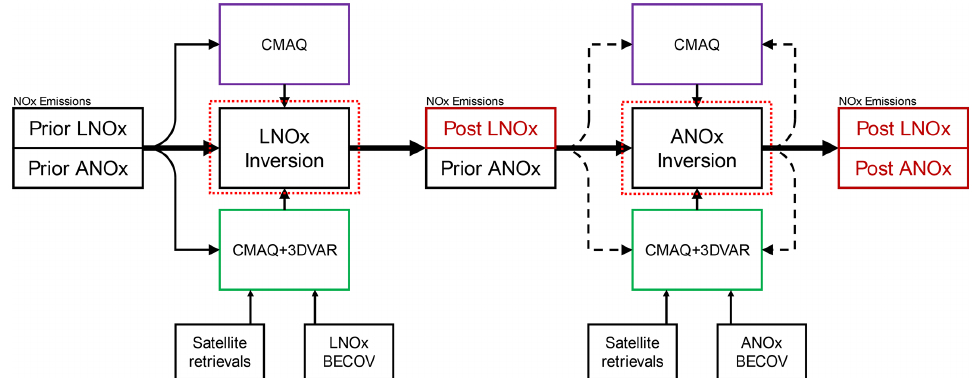
Figure 1. NO x emissions inversion framework. Lightning NO x (LNO x ) emissions are updated in the first step. Then, anthropogenic NO x (ANO x ) emissions are updated iteratively. CMAQ boxes represent air quality simulations without chemical data assimilation, and CMAQ + 3DVAR boxes represent air quality model simulations with chemical data assimilation. Satellite NO 2 retrievals and a background error covariance (BECOV) are inputs to the chemical data assimilation, described in Sect. 2.3. Red dotted lines around the inversion boxes correspond to the red dotted lines in Fig. 3, which details the inversion algorithm. Dashed black emissions input lines around the ANO x inversion represent the iterative process. Iteration and convergence criteria are described in Sect.